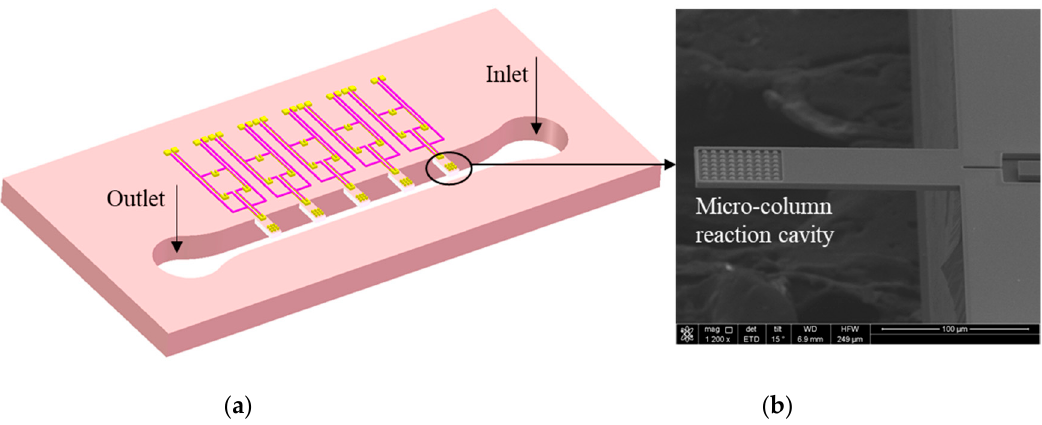
Figure 1. ( a ) Schematic of microcantilever biosensor and ( b ) scanning electron microscope (SEM) picture of the cantilever.